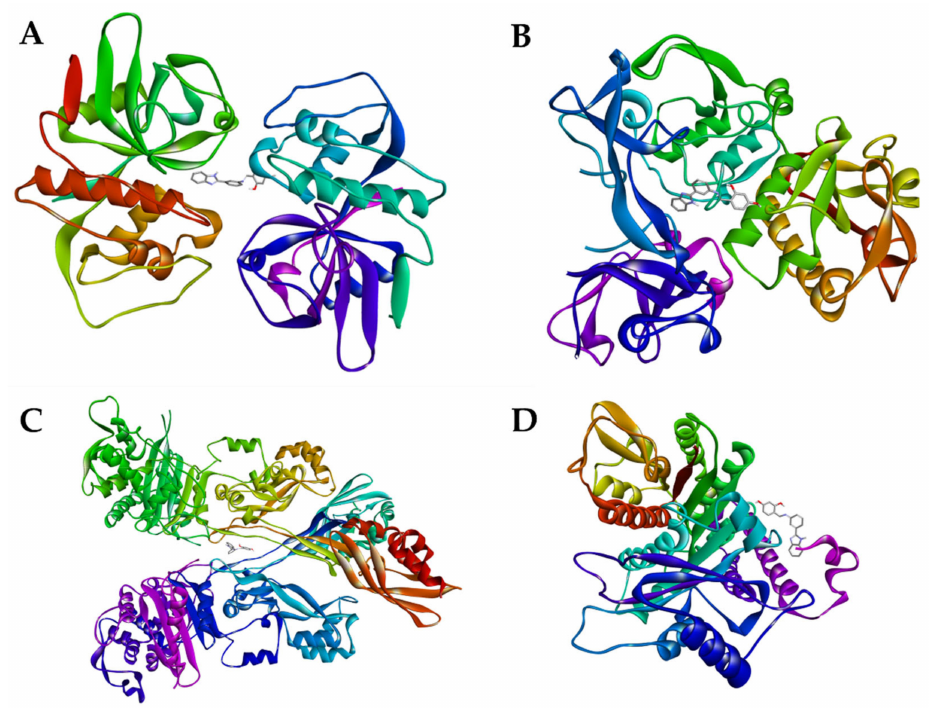
Figure 6. Receptors with L2 ligand: ( A ) Cruzain; ( B ) Leishmanin; ( C ) PBP2A; ( D )